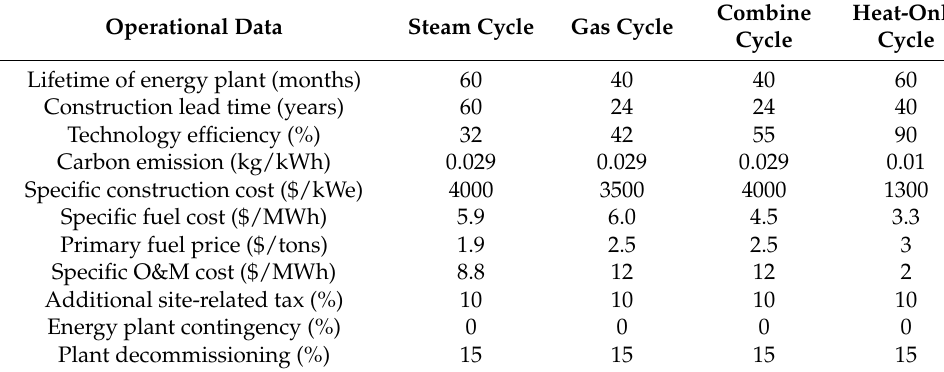
Table 7. Parameters of Power plant cycle [3].